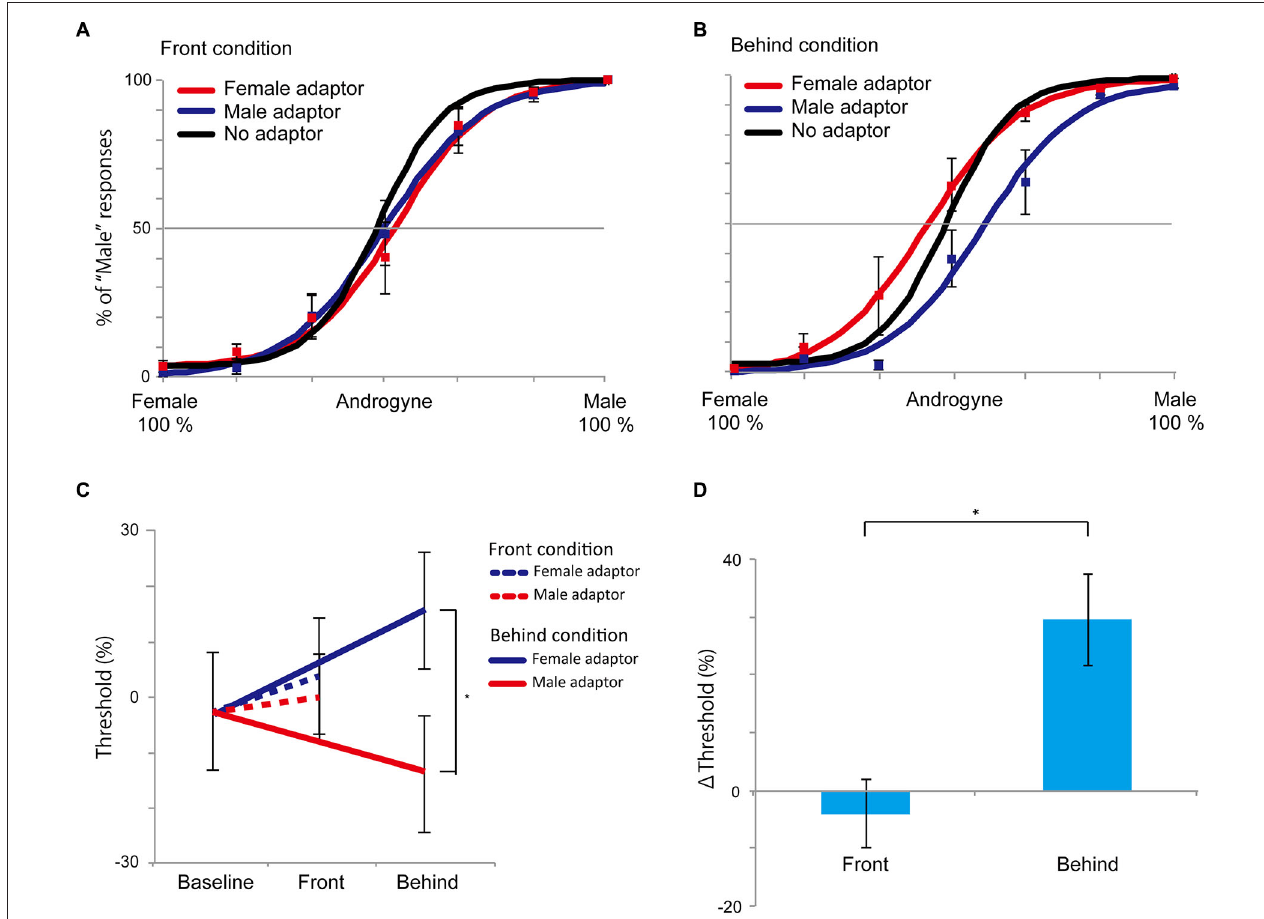
condition. (C) PSEs in Experiment 3. The dotted line denotes the front condition; the straight line denotes the behind condition. (D) Magnitudes of the aftereffects as measured by differences in PSEs between female and male adaptors in the front and behind conditions. All error bars represent standard errors (SEs) across participants. * P <